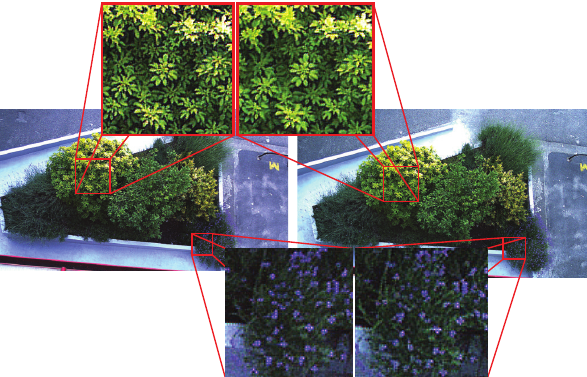
Figure 5: Visual quality check of the synchronization of the uEye stereo rig on bushes in windy